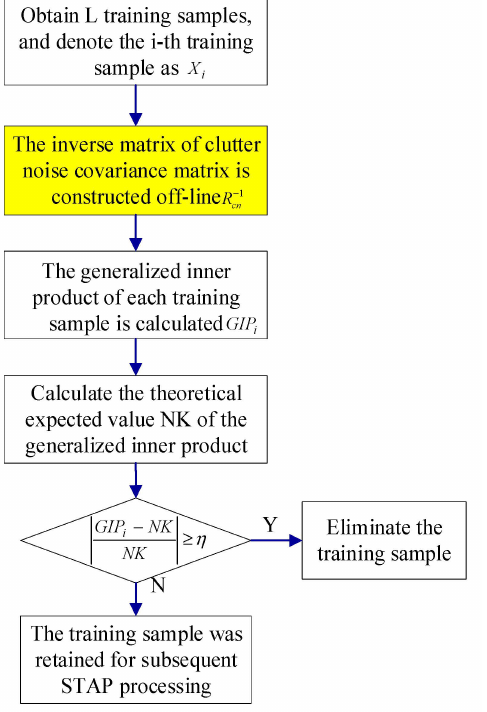
Figure 5. The flow chart for the clutter subspace characteristics-aided sample selection